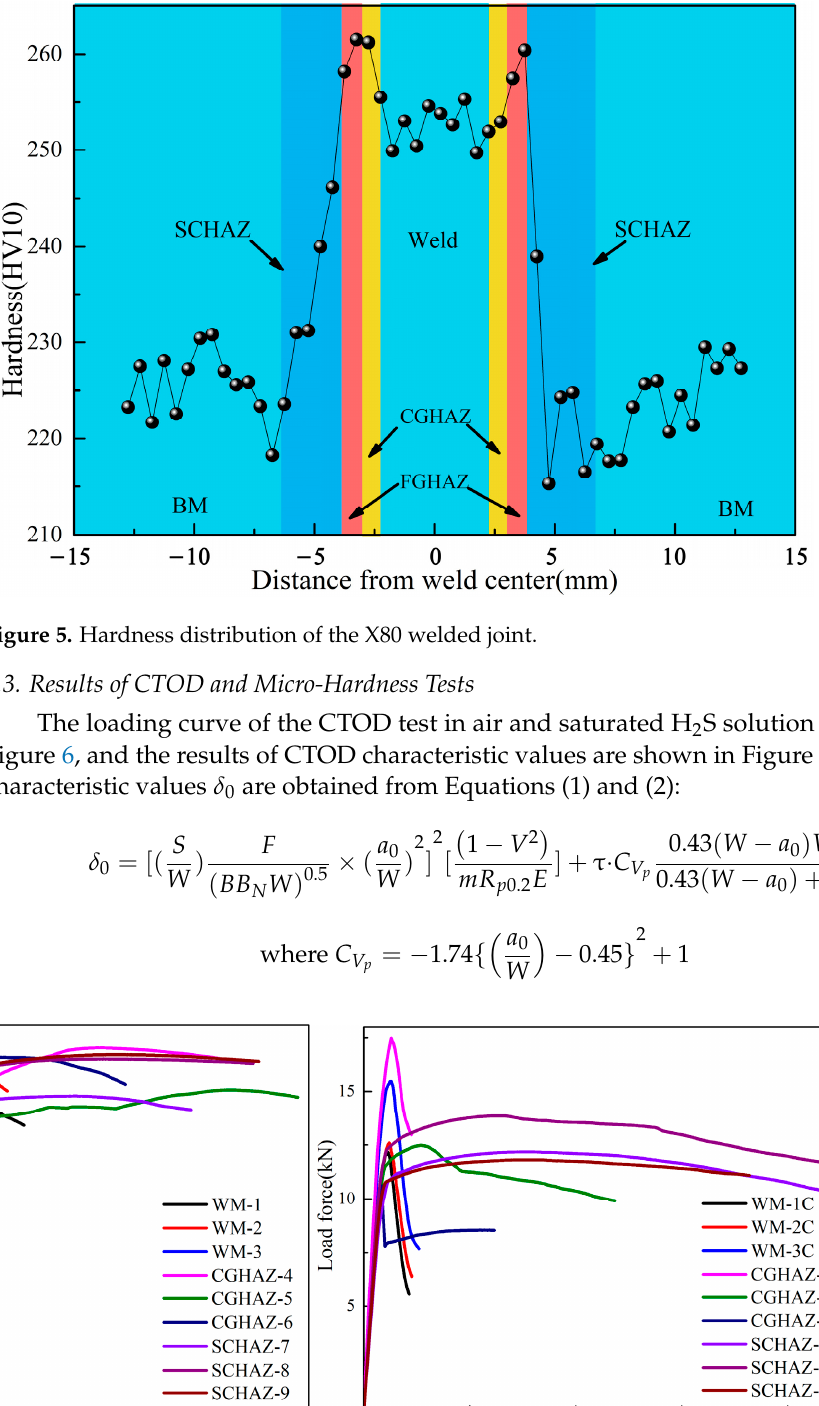
( f ) Figure 4. OM of the welded joint at different locations: ( a ) WM, ( b ) CGHAZ, ( c ) SCHAZ; SEM of the welded joint at different locations: ( d ) WM, ( e ) CGHAZ, ( f ) SCHAZ. 3.2. Micro ‐ Hardness Figure 5 shows the hardness distributions of the X80 welded joint, the hardness of WM was about 254 HV, and the microstructure of WZ was mainly AF (Figure 4a,d). The